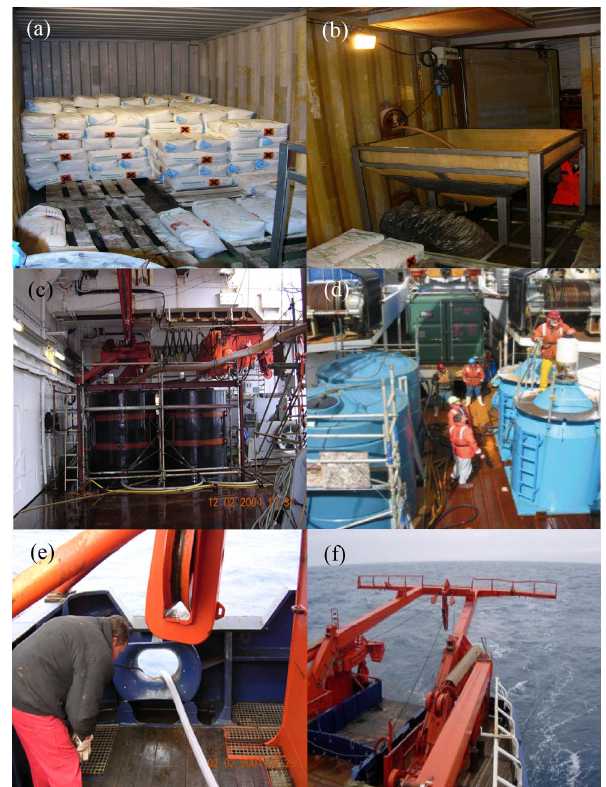
Figure 5. Photographs of the iron addition procedure (a–f) taken during the European Iron Fertilization Experiment (EIFEX), Sur- face Ocean–Lower Atmosphere Study (SOLAS) Air–Sea Gas Ex- change (SAGE), and Indo-German iron fertilization experiment (LOHAFEX). (a) Iron(II) sulfate bags. (b) The funnel used to pour iron and hydrochloric acid. (c) Tank system used for mix- ing iron(II) sulfate, hydrochloric acid, and seawater (Smetacek, 2015). (d) Preparation for release: the deck of RV Tangaroa with the iron tanks on the left and the SF 6 tracer tanks on the right (photo: Matt Walkington) (https://www.niwa.co.nz/ coasts-and-oceans/research-projects/sage, last access: 6 September 2018). (e) Outlet pipe connected to the tank system. (f) Pumping iron into the prop wash during EIFEX (Smetacek,